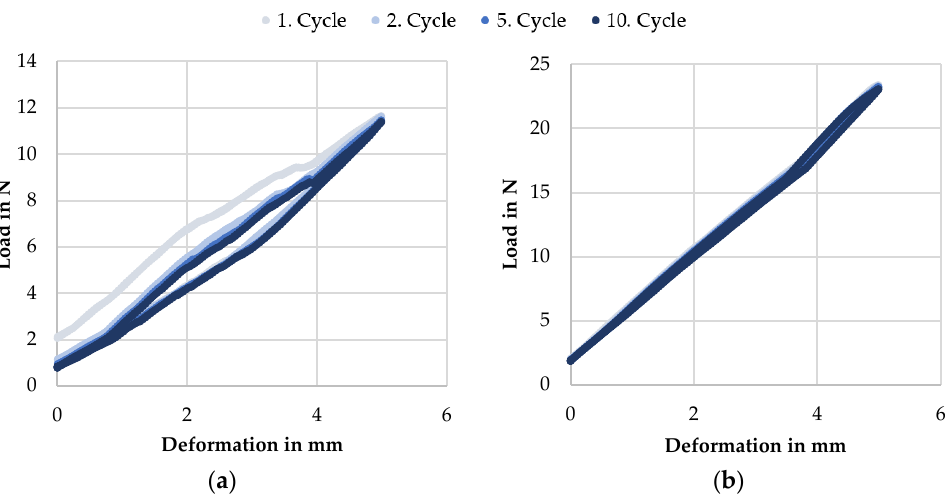
Figure 9. Compression behavior of the smart springs during load–deformation cycles exemplified on the basis of cycles 1, 2, 5, and 10 for ( a ) additively manufactured sample A3 (5 min PeP) and ( b ) conventionally shape set sample C1.